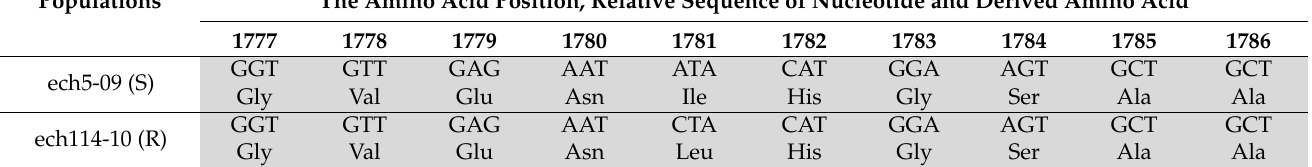
Table 5. Alignment of sequences for the ACCase gene. In bold and highlighted, the nucleotides encoding Ile-1781 in the susceptible population (S) and the mutation in the resistant ones.